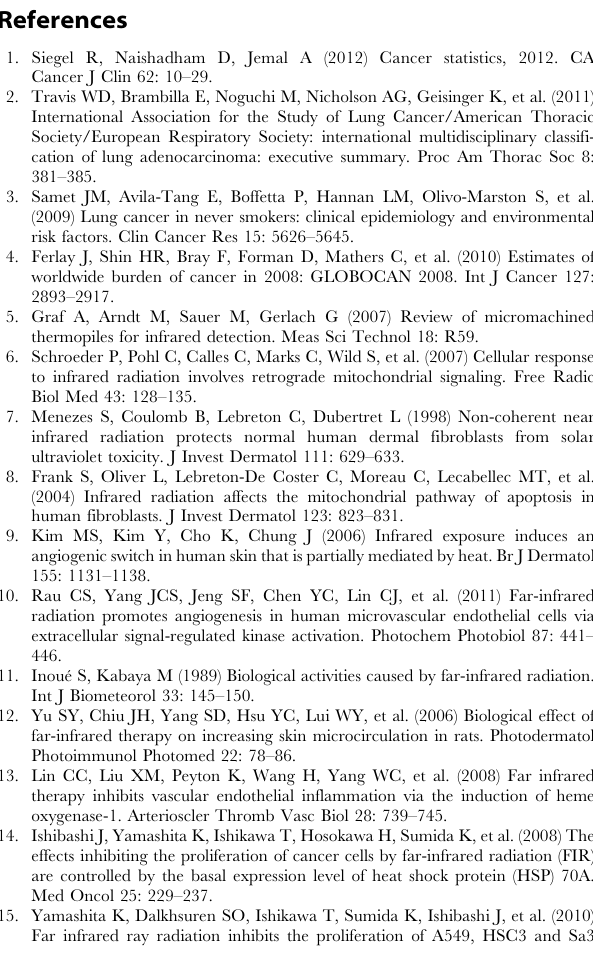
described in materials and methods. The data are presented as mean 6 SD from three independent experiments. (B) Cell morphology was observed by phase-contrast microscopy. Scale bar represents 50 m m. (TIF) Figure S3 Effect of MIR exposure on DNA double strain breaks in A549 cells. Cells were seeded onto the glass coverslip in 12-well plate, exposure by MIR for 48 hours, fixed for staining and visualized by fluorescence microscopy. (A) 53BP1 was labeled with anti-53BP1 antibody and corresponded FITC– conjugated secondary antibody (green), and nuclei were stained with DAPI (blue). (B) c -H2AX was labeled with anti- c -H2AX antibody following corresponded FITC–conjugated secondary antibody (green) and nuclei were labeled with DAPI (blue). Scale bar represents 10 m m.